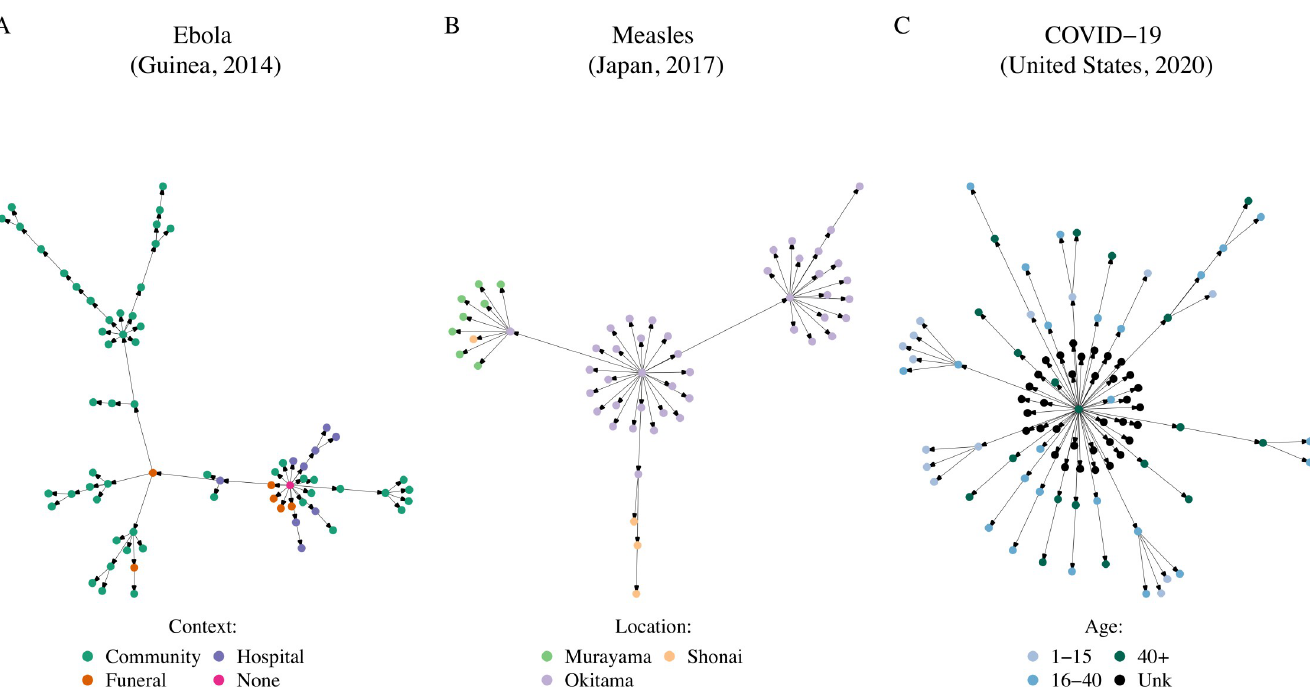
Fig 1. We compiled infectious disease transmission trees from the literature along with reported attribute information. AU : AbbreviationlistshavebeencompiledforthoseusedinFigs 1 (cid:0) 5 andS 1 (cid:0) S 7 : Pleaseverifythatallentriesarecorrect : Shown here are example trees in the database. (A) Ebola spread in different contexts [8]. (B) Measles spread in different locations [9]. (C) COVID-19 spread among age classes [10]. Primary sources for transmission trees are available in OutbreakTrees and listed in the Supporting information. OutbreakTrees may be accessed online at http://outbreaktrees.ecology.uga. edu. COVID-19, Coronavirus Disease 2019.